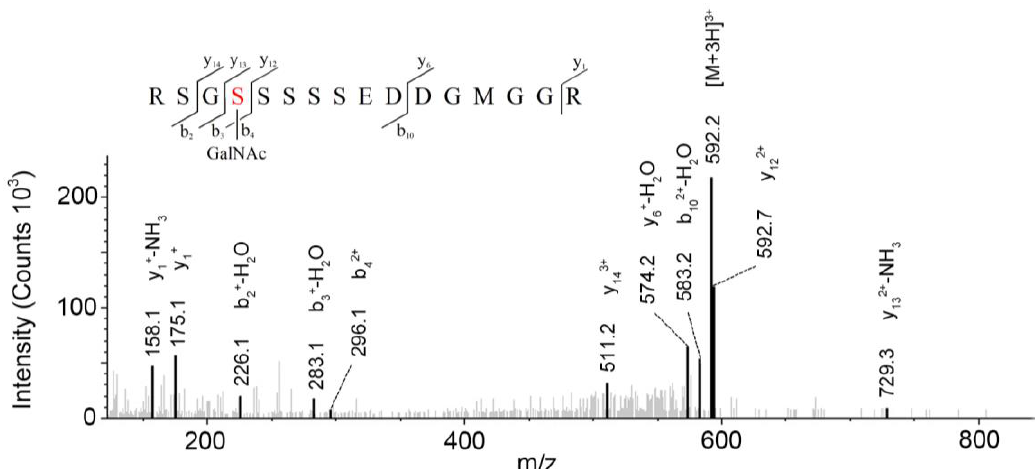
Figure 5. MS/MS spectra of glycopeptides whose peptide backbone is RSGSSSSSEDDGMGGR. The spectra are annotated according to the correct assignment which is RSGS( GalNAc )SSSSEDDGMGGR.